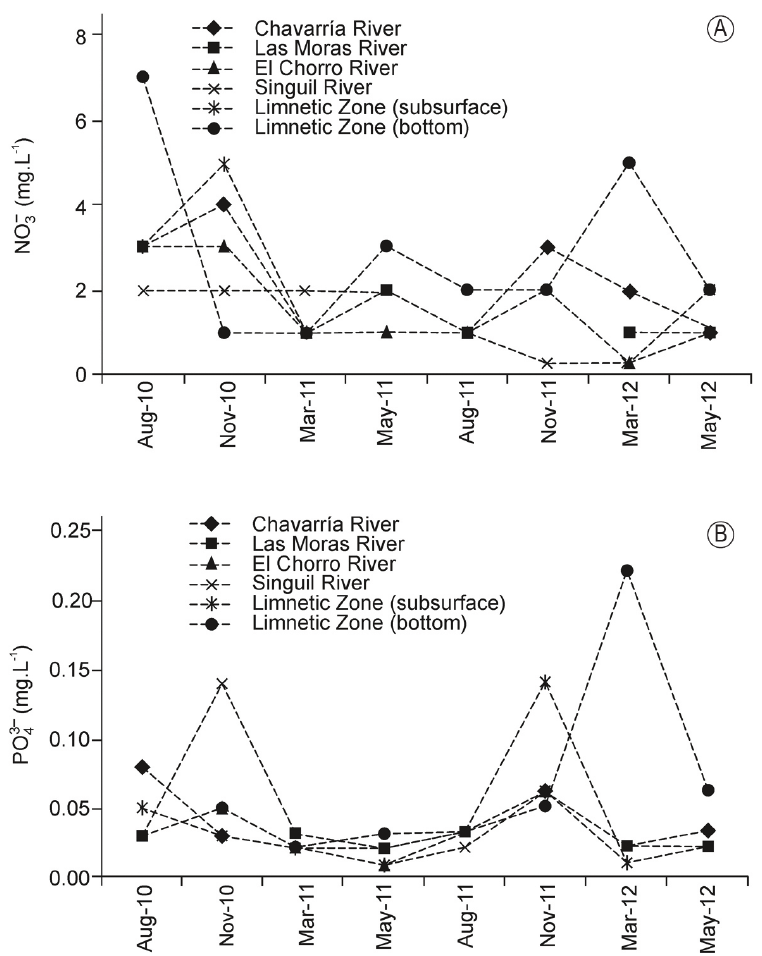
Figure 7. A -B. A. Nitrate fluctuation in the limnetic zone and the mouth of the tributaries and B. Concentrations of orthophosphate in the limnetic zone and the mouth of the